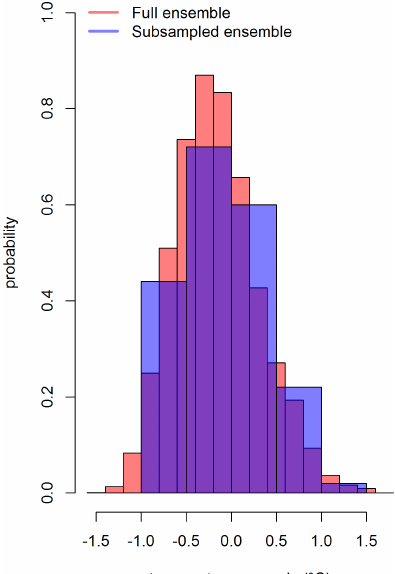
Figure C1. Distribution of the grid box (long and lat are 72 . 5 ◦ and 32 . 5 ◦ , respectively) that includes Lahore for February 1932. The full ensemble consists of 100000 grid boxes (Sect. 4.3), and the subsampled ensemble consists of 100 grid boxes based on Latin hypercube sampling.